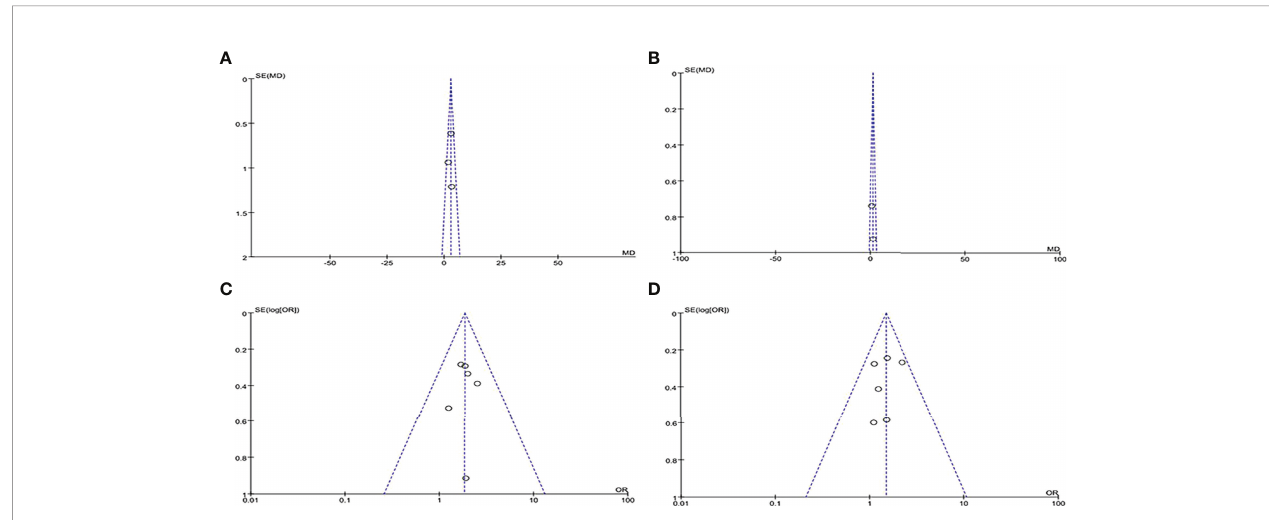
FIGURE 4 | Funnel plots of included literature: (A) PSQI score funnel plot; (B) ESS score funnel plot; (C) Long sleep duration DR funnel plot; (D) Short sleep duration DR funnel plot.